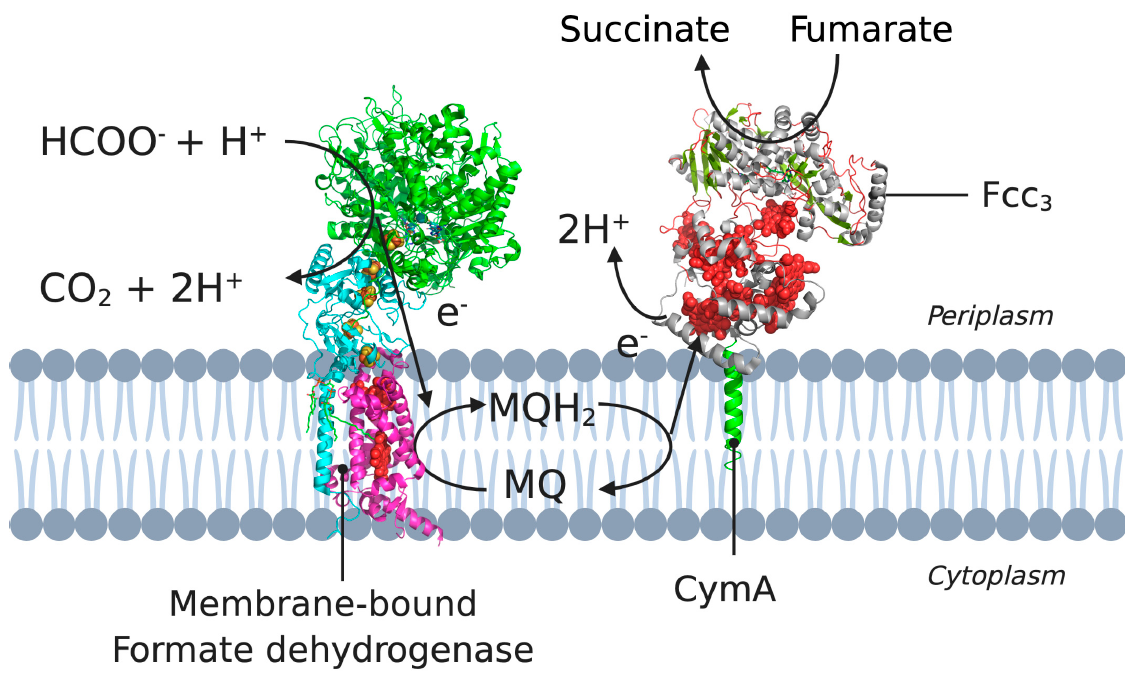
Figure 3. A cross-section of the cytoplasmic membrane of S. oneidensis showing the electron pathway for the reduction of CymA. Example pathway starting from formate oxidation (by formate dehydrogenase) to the electron transfer between MQH 2 and CymA, to NapAB. 3D structural cartoons of the Escherichia coli formate dehydrogenase (PDB:1KQG) [56], the Desulfovibrio vulgaris NrfH (PDB:2J7A) [5], and the Shewanella frigidimarina flavocytochrome c 3 (PDB:1Y0P) [6] were rendered with PyMol and the figure compiled in BioRender.com [8].